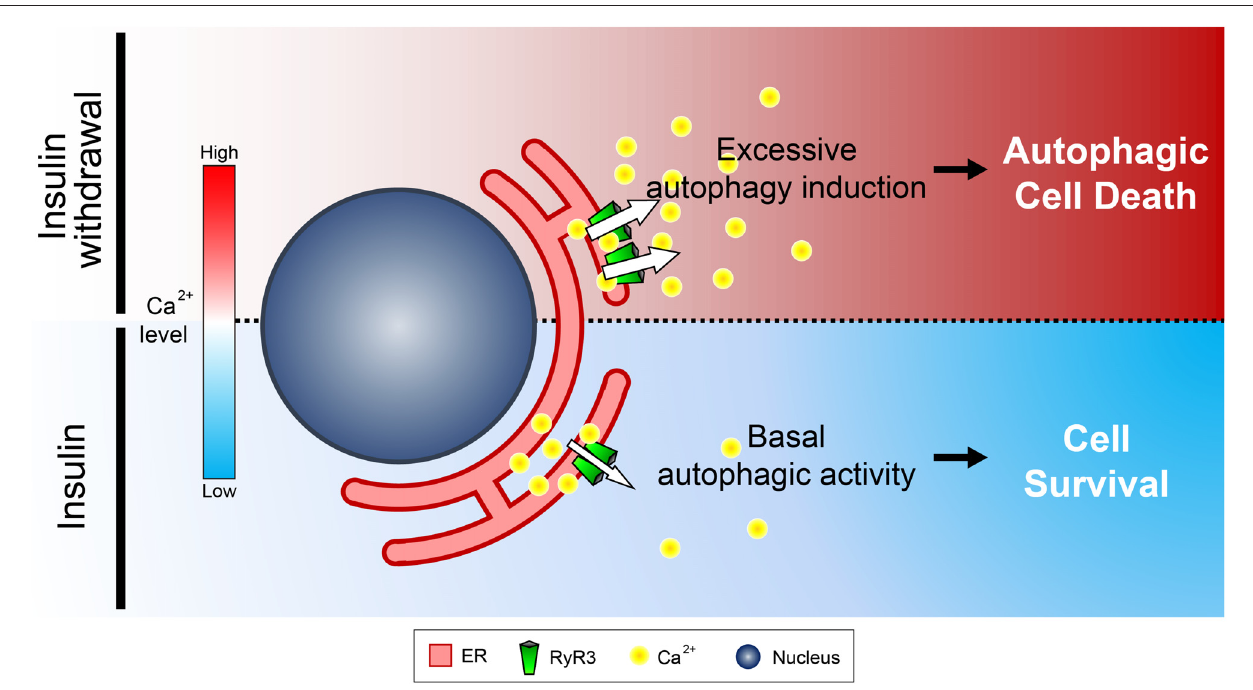
FIGURE 9 | Schematic diagram illustrating the role of ER-to-cytosol Ca 2 + in regulation of survival and death of NSCs in insulin withdrawal model. Presence of insulin constitutively ensures proper distribution of intracellular Ca 2 + which maintains homeostasis of HCN cells. Inactivation of the pro-survival insulin signaling pathway by insulin withdrawal leads to increased expression and activation of RyR3 which subsequently discharge Ca 2 + from the ER, the major intracellular Ca 2 + store. Increase in cytosolic Ca 2 + subsequently triggers a signaling cascade that induces ACD in HCN